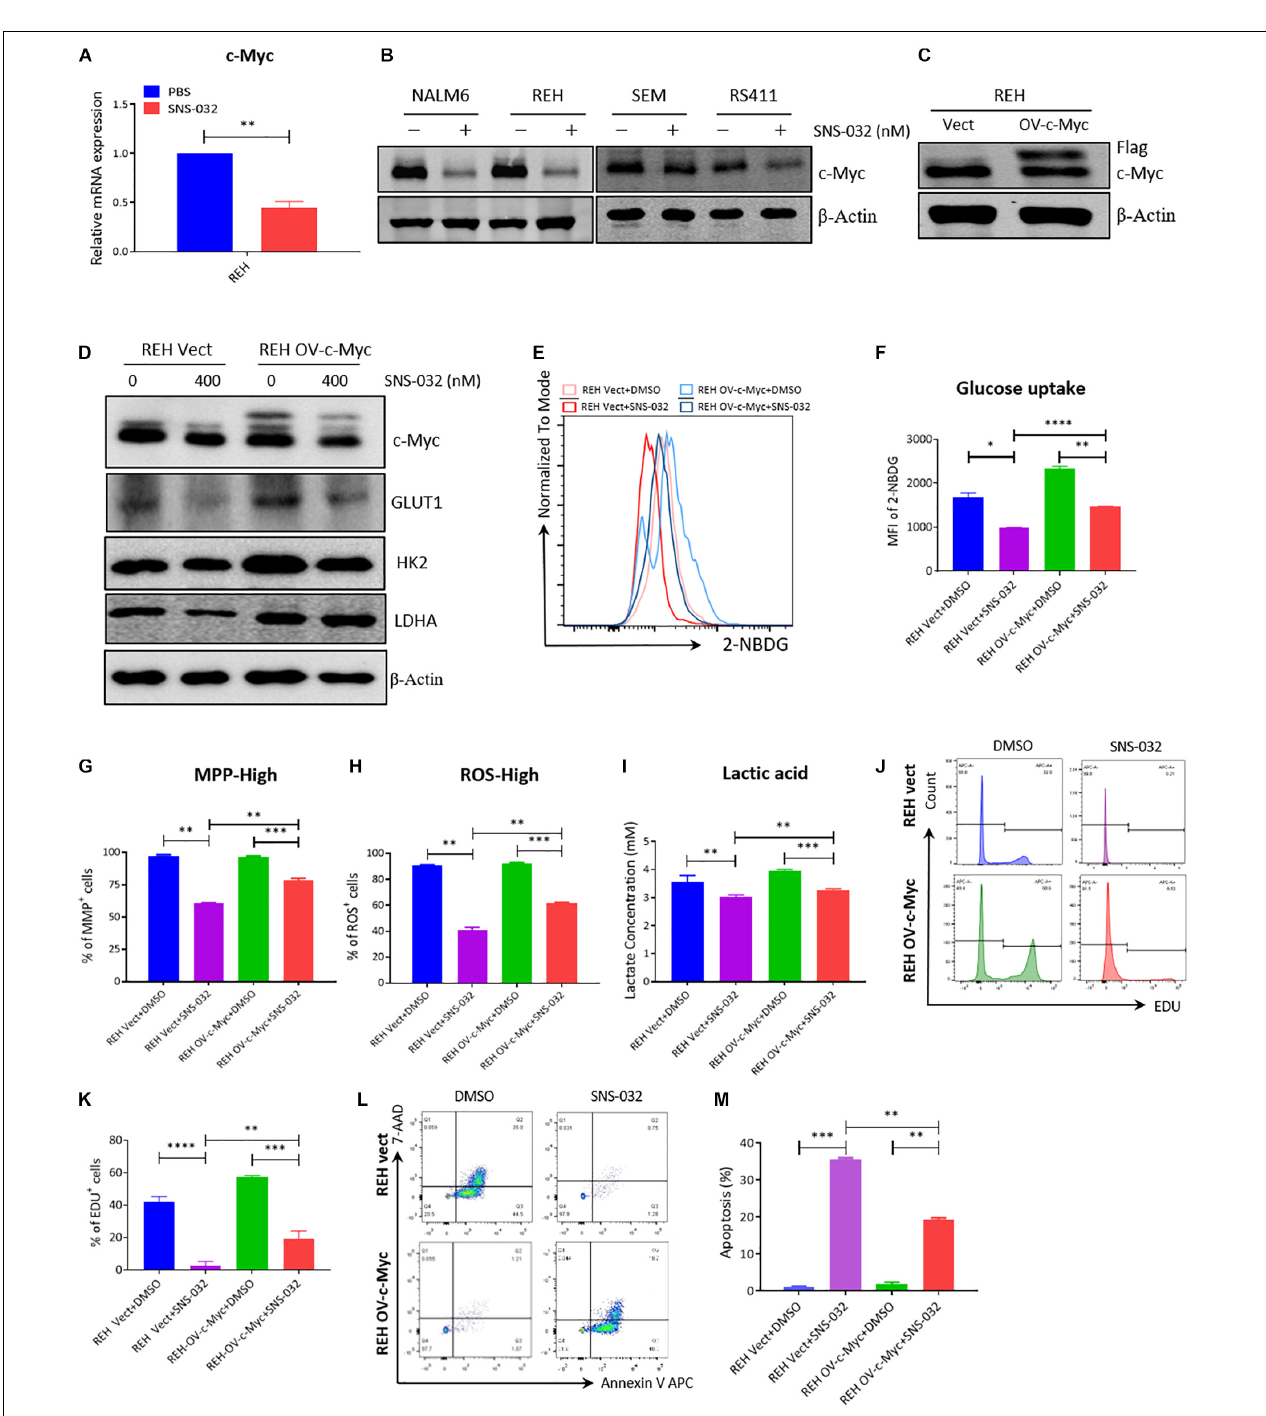
FIGURE 6 | Overexpressed c-Myc in B-ALL cells rescues CDK9i induced cell apoptosis. (A) Relative mRNA expression levels of c-Myc in REH cells measured by qRT-PCR. (B) Protein expression of c-Myc in B-ALL cells determined by Western blot analysis. (C) Overexpressed level of c-Myc in REH cells detected by Western blot analysis. (D) Levels of HK2 and LDHA in c-Myc-overexpressing REH cells tested by Western blot analysis after intervention with SNS-032 at 0 and 400 nM. (E) Glucose uptake of vector and c-Myc-overexpressing REH cells was analyzed by flow cytometry. (F) Statistical analysis of glucose uptake of REH cells. (G,H) MMP and total ROS of vector and c-Myc-overexpressing REH cells were analyzed by flow cytometry. (I) Quantification of intracellular lactate in vector and c-Myc-overexpressing REH cells using the lactate assay kit. (J) EdU-labeled cell cycle of c-Myc-overexpressing REH cells analyzed by flow cytometry. (K) Statistical analysis of EdU-positive REH cells. (L) Annexin V- and 7-AAD-labeled cell apoptosis of c-Myc-overexpressing REH cells was analyzed by flow cytometry. (M) Statistical analysis of cell apoptosis rates of B-ALL cells. B-ALL cells were treated with SNS-032 for 24 h. Values were shown as mean ± SEM. ∗ p < 0.05, ∗∗ p < 0.01, ∗∗∗ p < 0.001 and ∗∗∗∗ p < 0.0001.